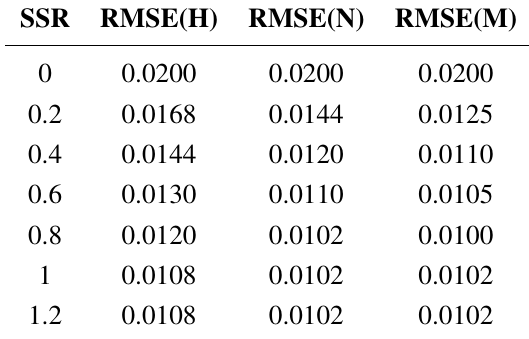
Table 6. Comparison on RMSE.